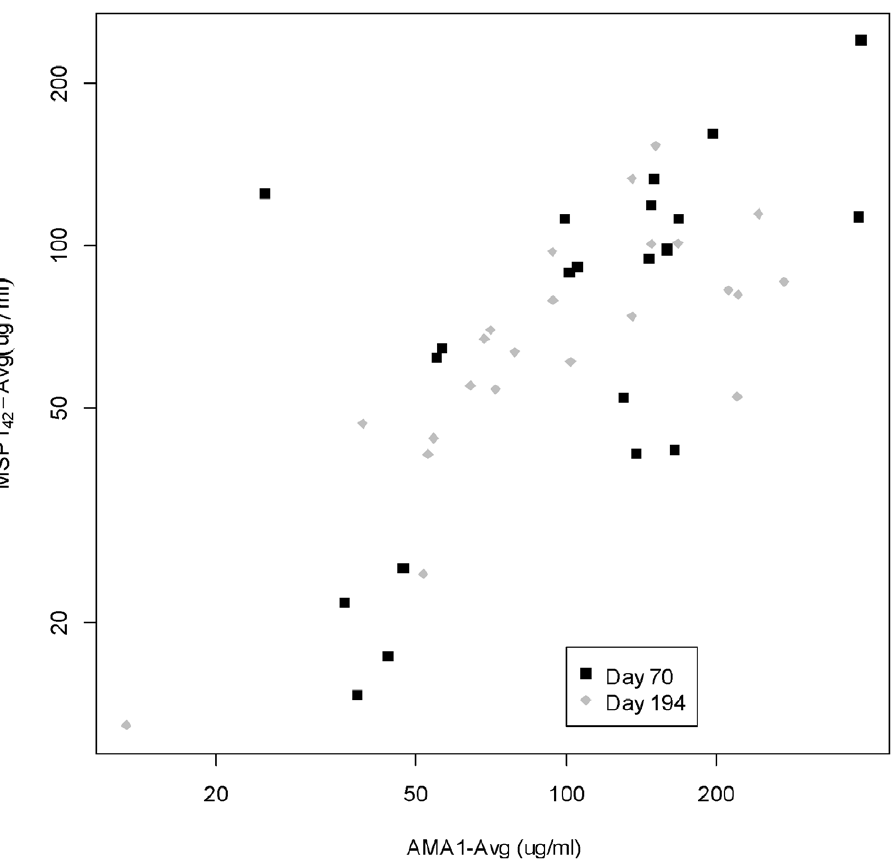
Figure 5. Correlation between average anti-AMA1 and -MSP1 42 antibody responses at Day 70 and Day 194 (two weeks after second and third vaccinations). Day 70: Spearman correlation, r=0.60 [95% CI 0.23, 0.82]; Day 194: Spearman’s correlation, r=0.75 [0.50,0.89].